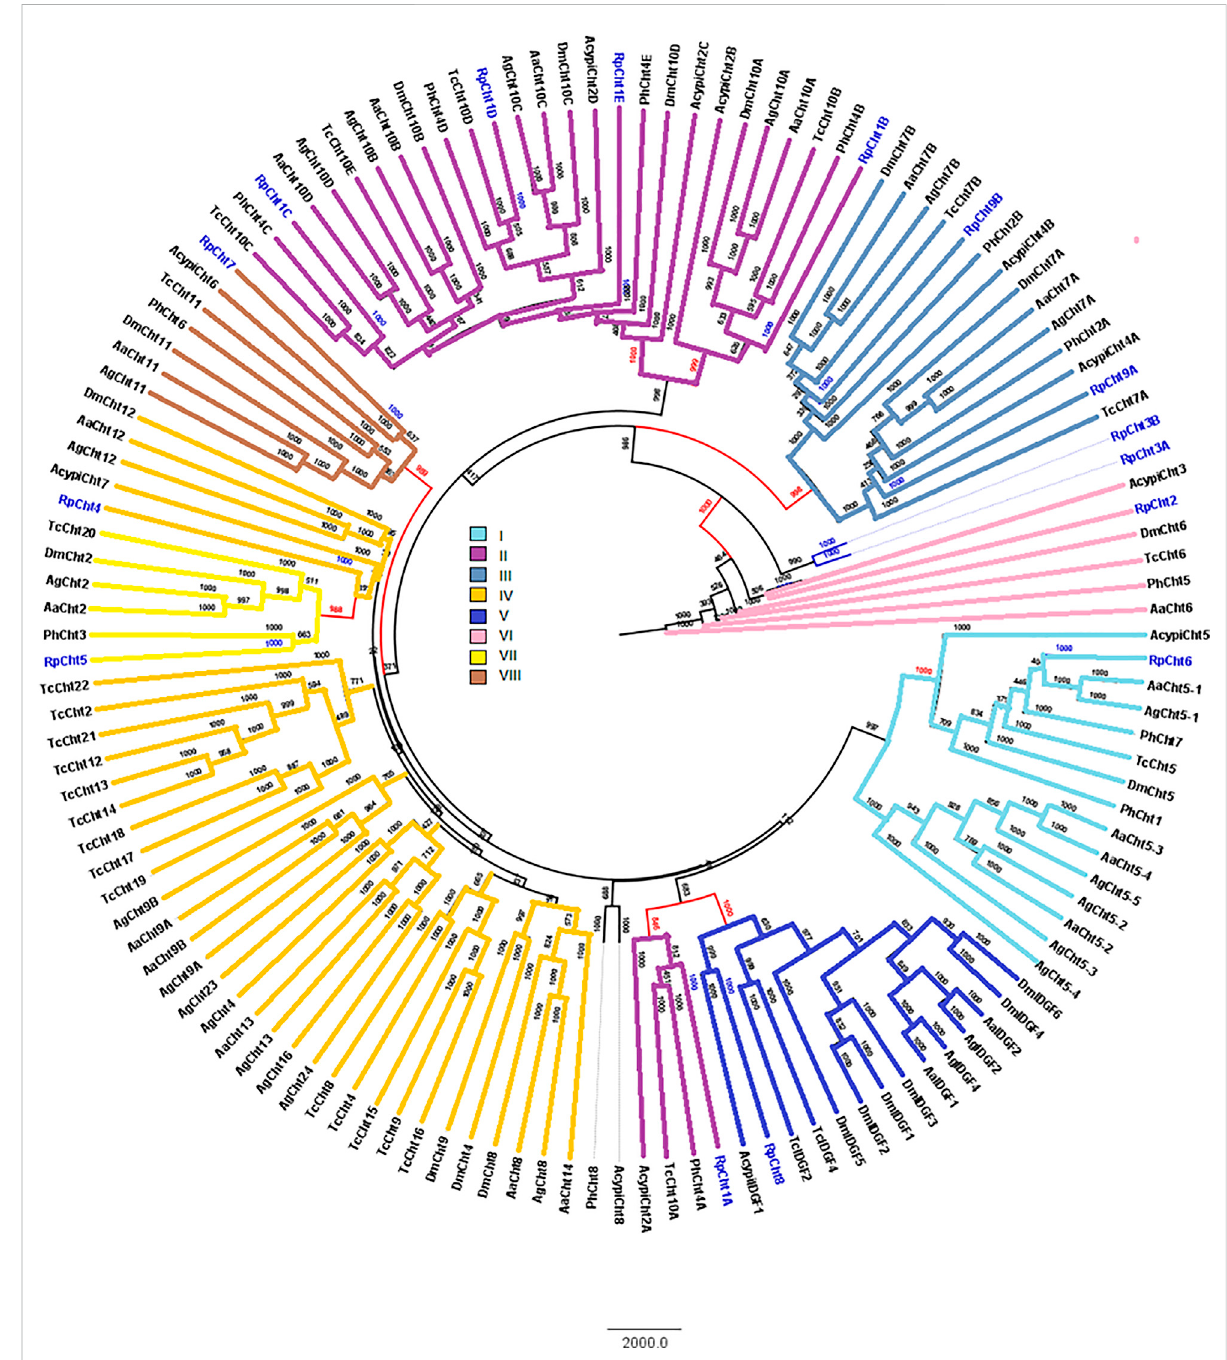
FIGURE 3 Phylogenetic analysis of chitinases catalytic domains from seven insect species based on protein sequences. Rp: Rhodnius prolixus ; Ag, Anopheles gambiae ; Aa, Aedes aegypti ; Tc, Tribolium castaneum ; Dm, Drosophila melanogaster ; Ph, Pediculus humanus ; Acypi, Acyrthosiphon pisum . Phylogenetic tree of insect chitinases generated by FigTree software (http://tree.bio.ed.ac.uk/software/ fi gtree/) after alignment using ClustalW (www.ebi.ac.uk/clustalW). Bootstrap values were obtained by the neighbor-joining method using 10,000 replications. Colors and Roman numbers represent chitinase